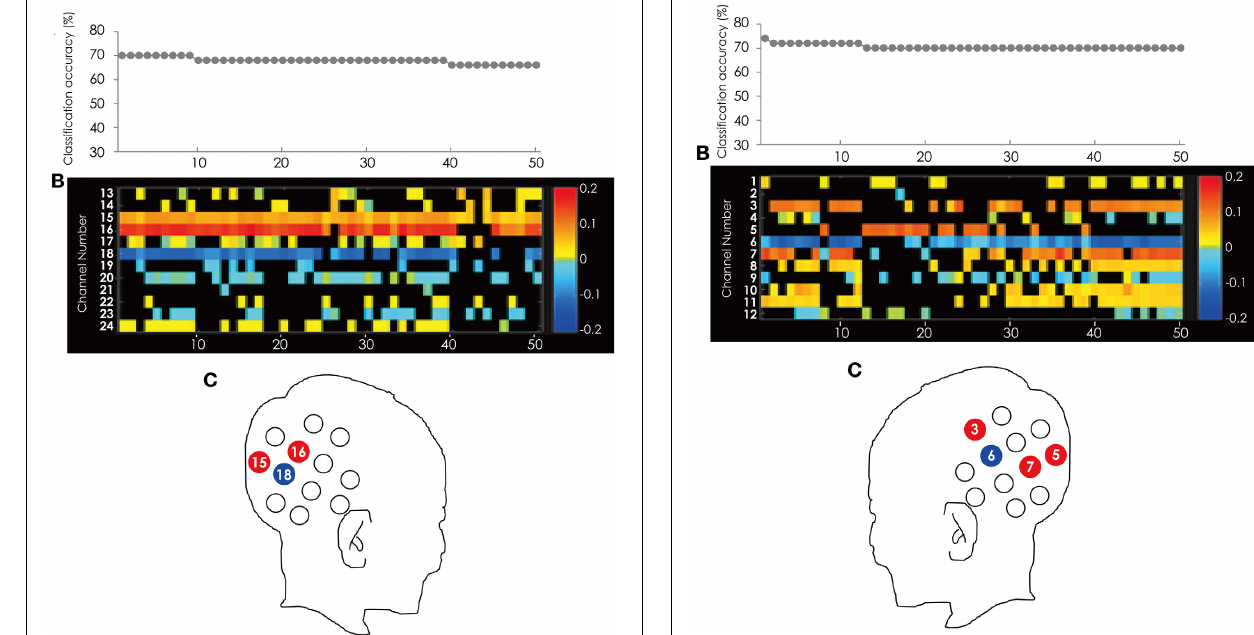
FIGURE 3 | (A) The classification accuracy corresponding with the best 50 subsets consisted from the channels in the right hemisphere. (B) The channel numbers in the subsets represented in (A) . (C) The position of the channels referred in the text.